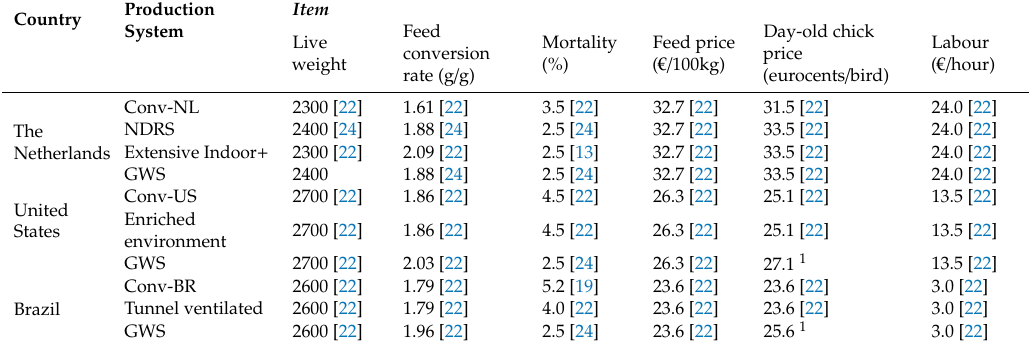
Table A1. Overview of main technical inputs and prices used in the economic model of Gocsik et al. [9].